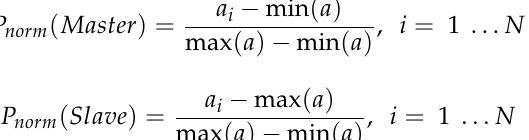
Figure 13. Estimated perturbation of master for end effector.